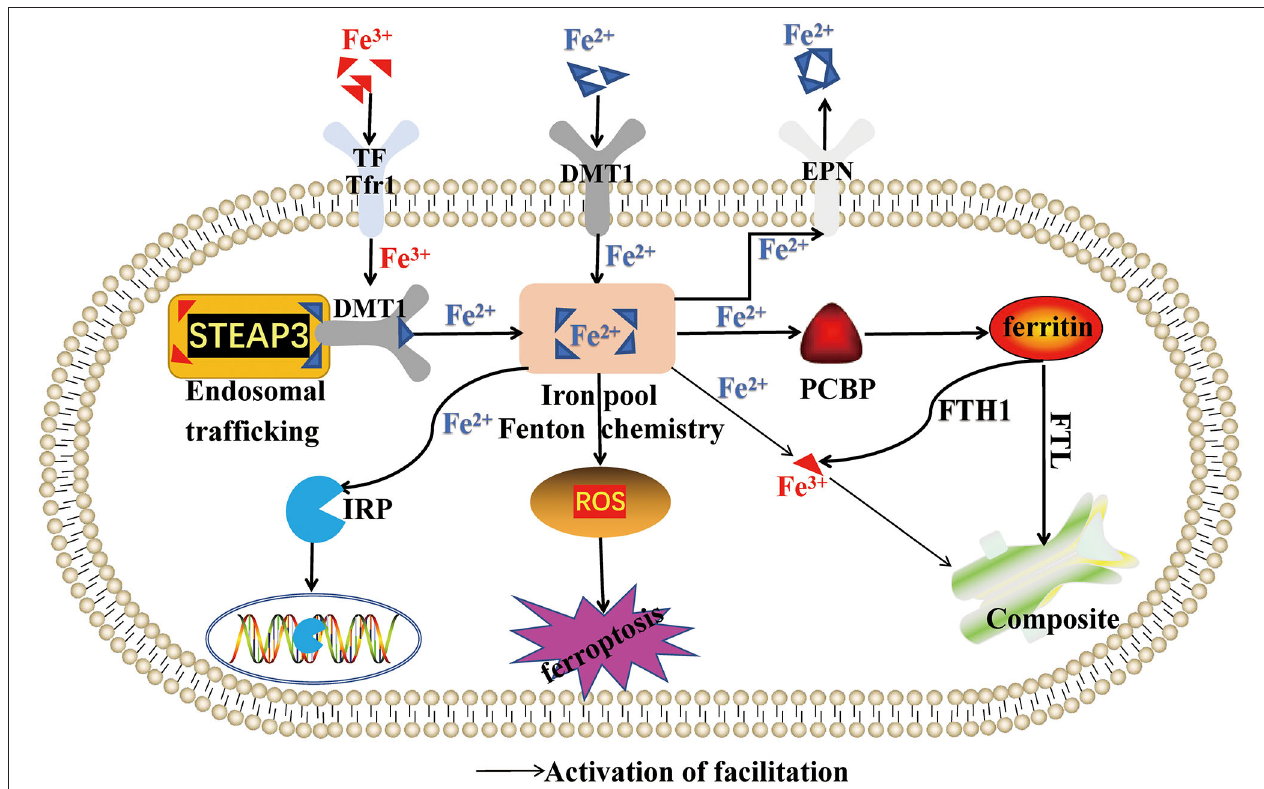
FIGURE 1 | Regulation of abnormal iron metabolism on ferroptosis. This figure summarizes the regulatory effect of Fe 2 + and Fe 3 + on ferroptosis. The black arrow represents the activation of the regulatory role of Fe 2 + and Fe 3 + .